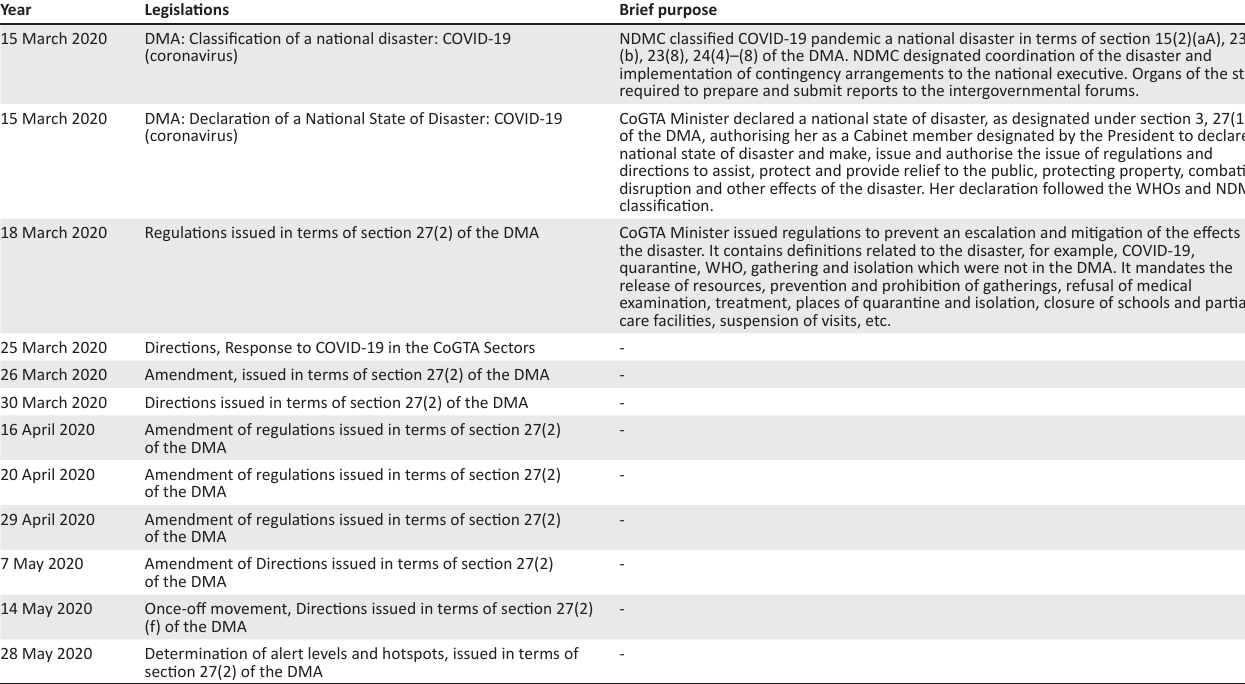
TABLE 1: COVID-19 regulations and guidelines issued in South Africa from March to May